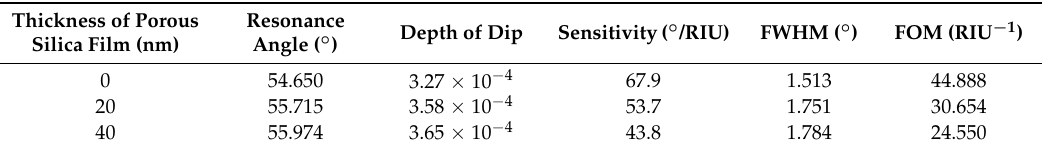
Figure 4. The angular spectra of the SPR sensors with 0 (traditional SPR sensor), 20, and 40 nm thick 20% porosity porous silica film ( n ps = 1.365). Table 1. The performance parameters of the SPR sensors with 0 (traditional SPR sensor), 20, and 40 nm thick 20% porosity porous silica film ( n ps = 1.365).